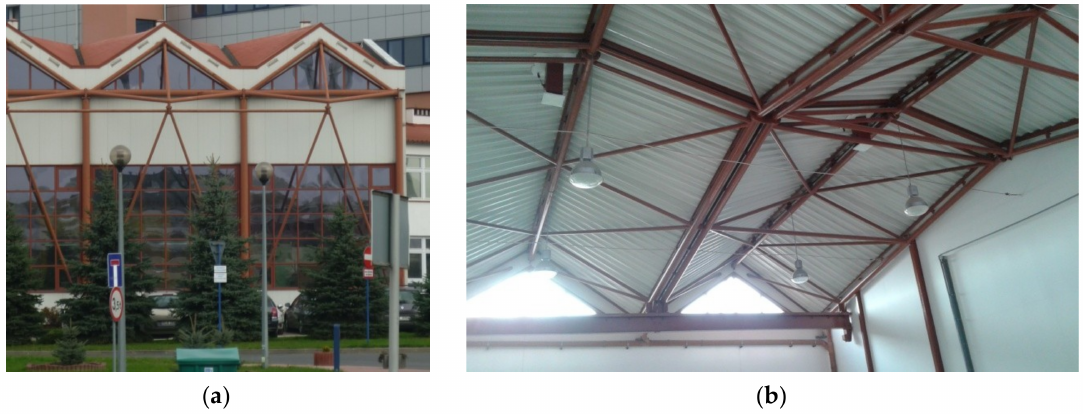
Figure 1. A roof shell structure composed of many transformed fold shell strips: ( a ) view from the outside; ( b ) view from the